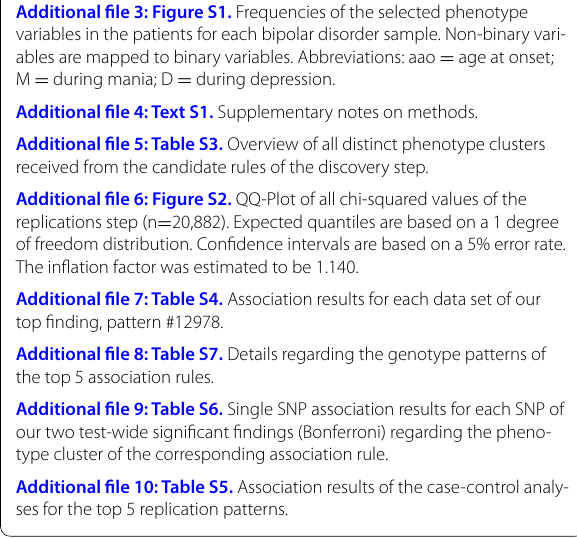
Listed are the rule identifier (PID), the counts per group of the contingency tables, the p-values based on the Chi squared test along with the odds ratios including confidence intervals (CI), and results from two multiple correction methods (based on 20,882 tests). The coding of the groups is as follow: G, if genotype pattern is present, g if not; P, if phenotype pattern is present, p if not. FDR false discovery